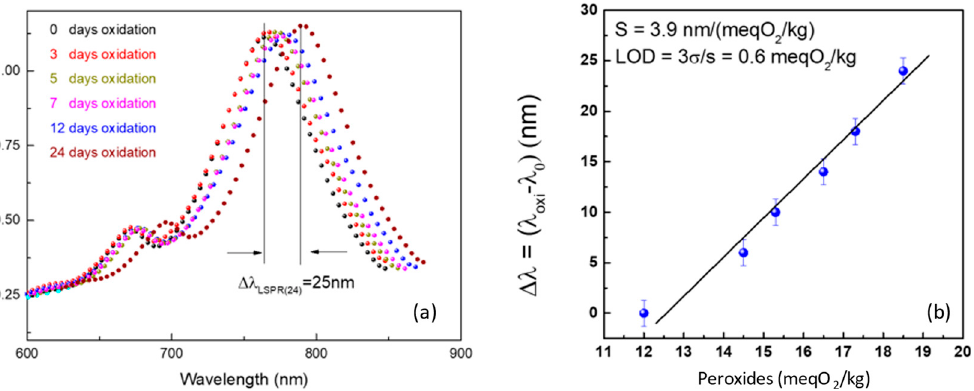
Figure 9. ( a ) Optical absorption measurements in the UV-VIS spectral range and the relative calibration curve ( b ) have been reported; the plasmonic transducer response have been calculated by considering the spectral shift of LSPR absorbance peak in presence of EVO oil at different oxidation states and therefore increasing number of peroxides.